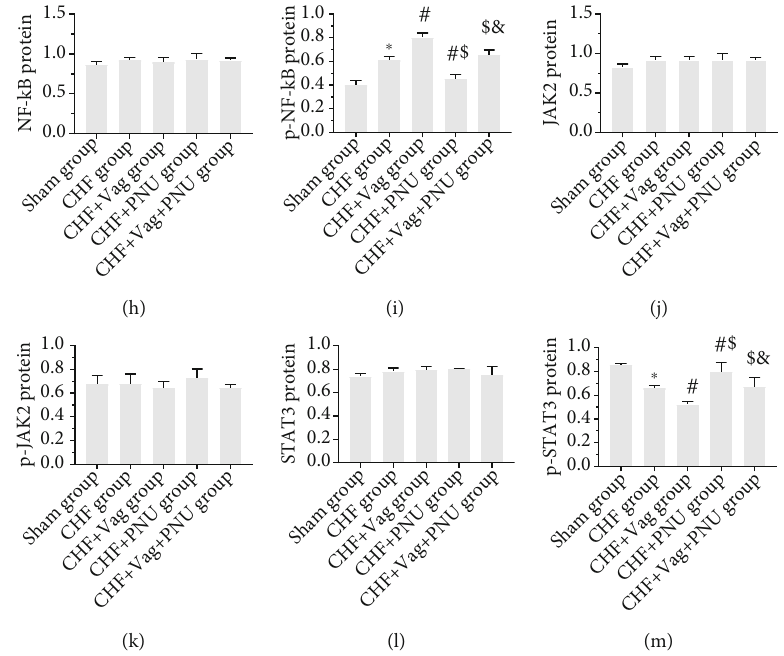
Figure 8: E ff ects of cholinergic elicitation on myocardial mitochondrial dynamics and the activities of NF- κ B and JAK2/STAT3 pathway. Western blot results and quantitative statistics for Drp1, Fis1, Mfn1, Mfn2, Opa1, α 7nAChR, NF- κ B, P-NF- κ B, JAK2, P-JAK2, STAT3, and p-STAT3 (a – m). ∗ P < 0 : 05 vs. Sham group. # P < 0 : 05 vs. CHF group. $ P < 0 : 05 vs. CHF+Vag group. & P < 0 : 05 vs. CHF+PNU group. Drp1: dynamin-related protein 1; Fis1: fi ssion, mitochondrial 1; Mfn1: mitofusin 1; Mfn2: mitofusin 2; Opa1: OPA1 mitochondrial dynamin-like GTPase; α 7nAChR: α 7-nicotinic acetylcholine receptor; NF- κ B: nuclear factor kappa B; p-NF-KB: phosphorylated nuclear factor kappa B; JAK2: Janus kinase 2; p-JAK2: phosphorylated Janus kinase 2; STAT3: signal transducer and activator of transcription 3; p-STAT3: phosphorylated signal transducer and activator of transcription